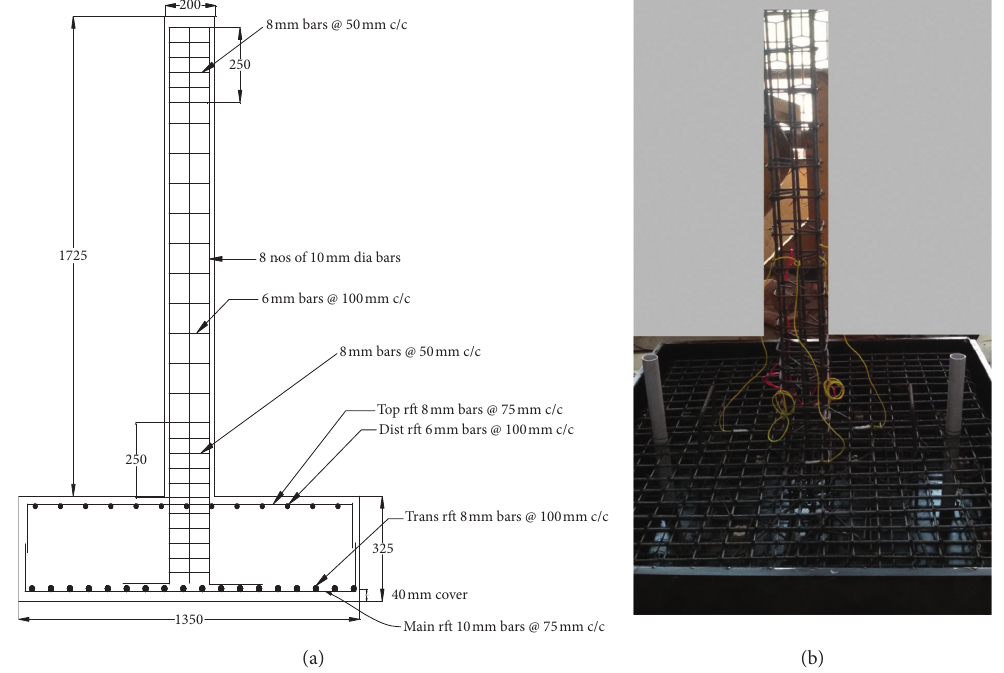
Figure 5: Reinforcement details of monolithic specimen.